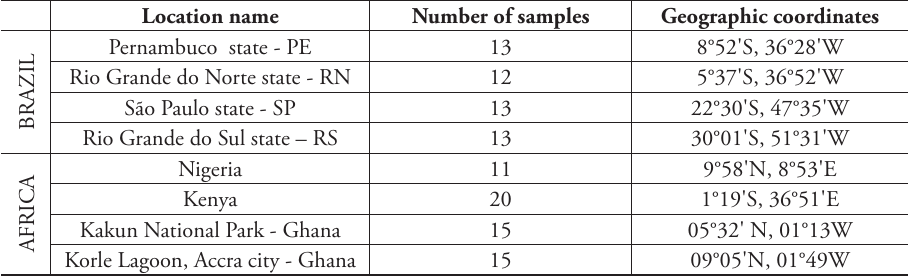
Table S1. Number of samples and locations in Brazil and